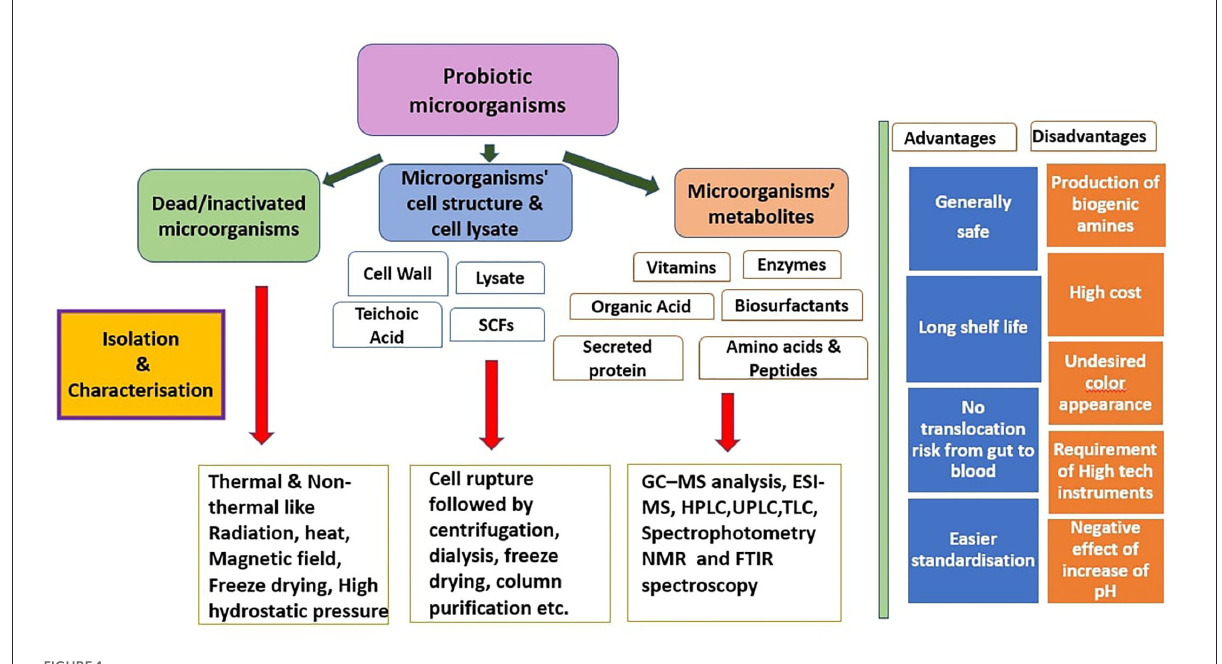
FIGURE1 Postbiotic components: production and